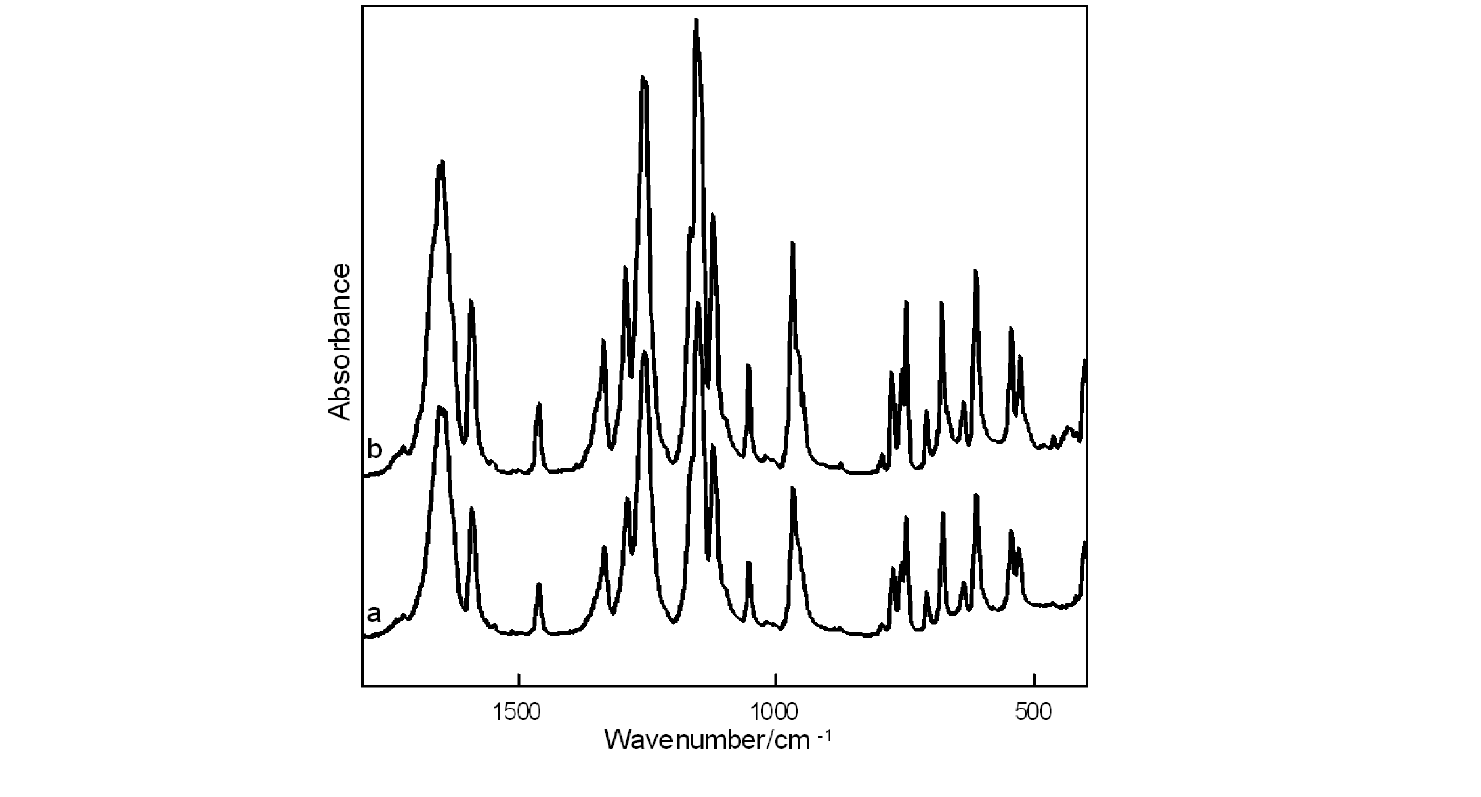
Fig. 6 The (a) RT and (b) LNT IR spectrum of K 3 (sac) 3 ¢ 2H 2 O in the 2000-400 cm ¡ 1